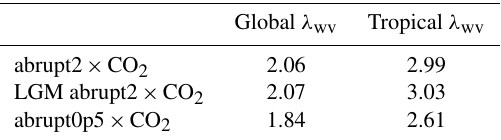
Table 6. Global and tropical (30° ◦ S–30 ◦ N) water vapor feed- back λ wv values computed with the PRP method for three simu- lations performed with